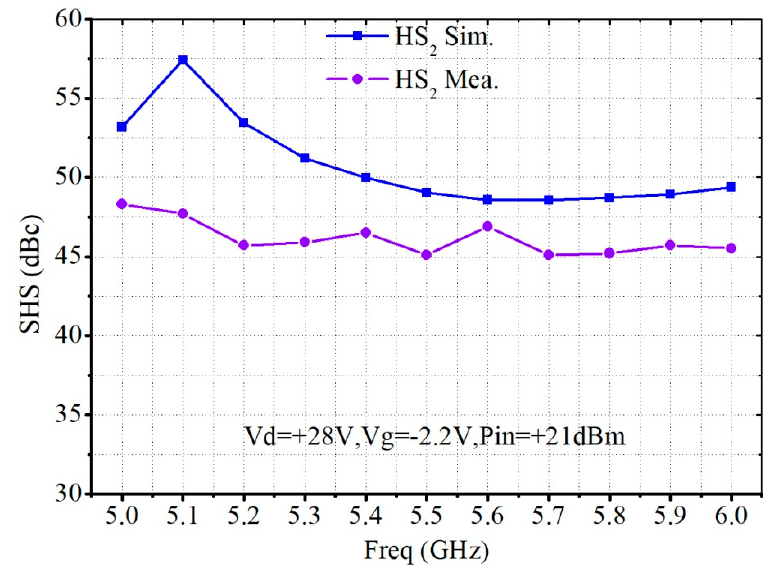
Figure 11. Simulated and measured SHS of the proposed C-band 30 W PA MMIC.